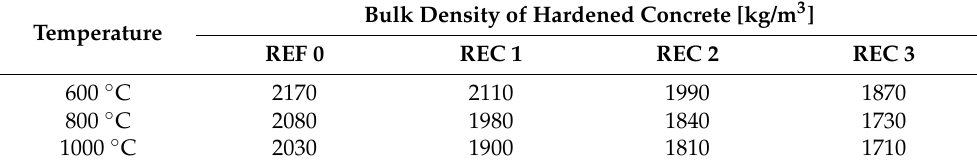
Table 5. Change in the bulk density of hardened